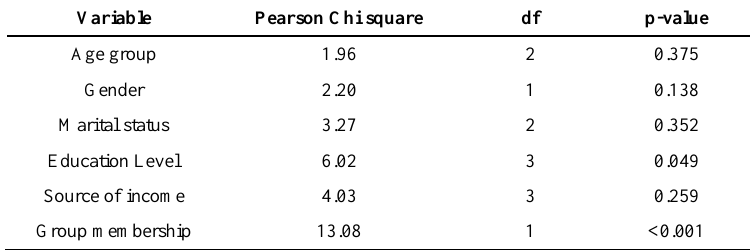
Table 3. Influence of socio-demographic characteristics on Irish potato value addition Variable